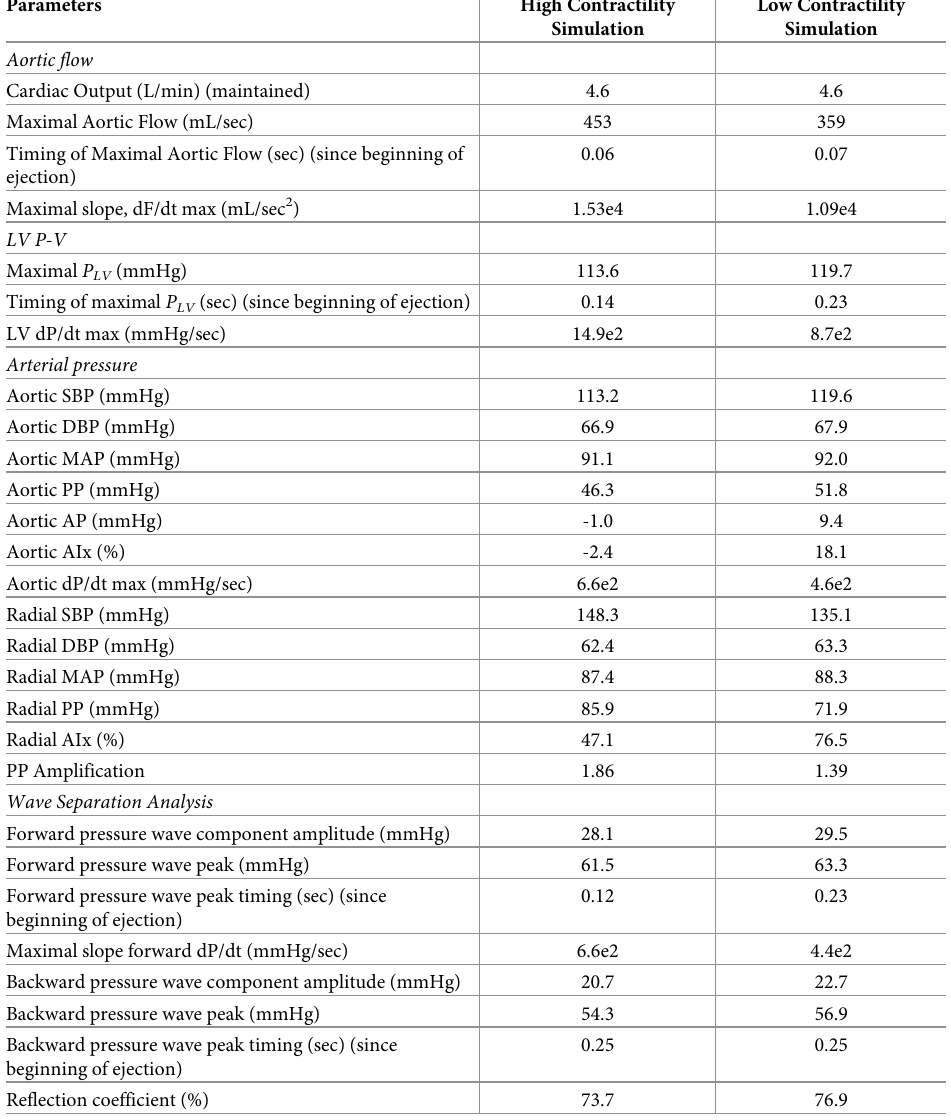
Table 2. Comparison of hemodynamic characteristics between the two contractility